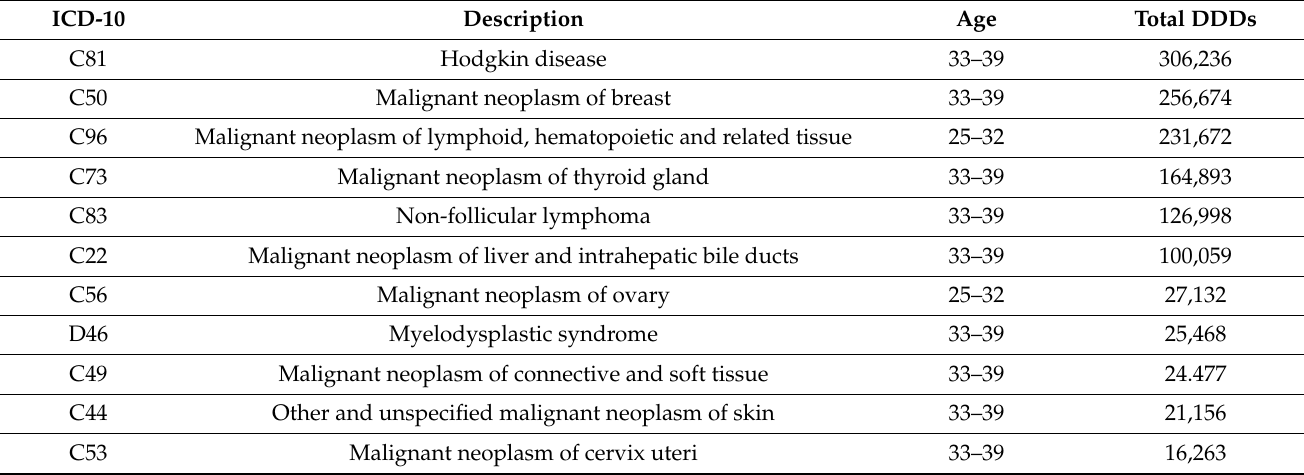
Figure 13. DDD consumption for males + females, ATC group Jxxx. Table 5. Total DDDs for ATC group Cxx